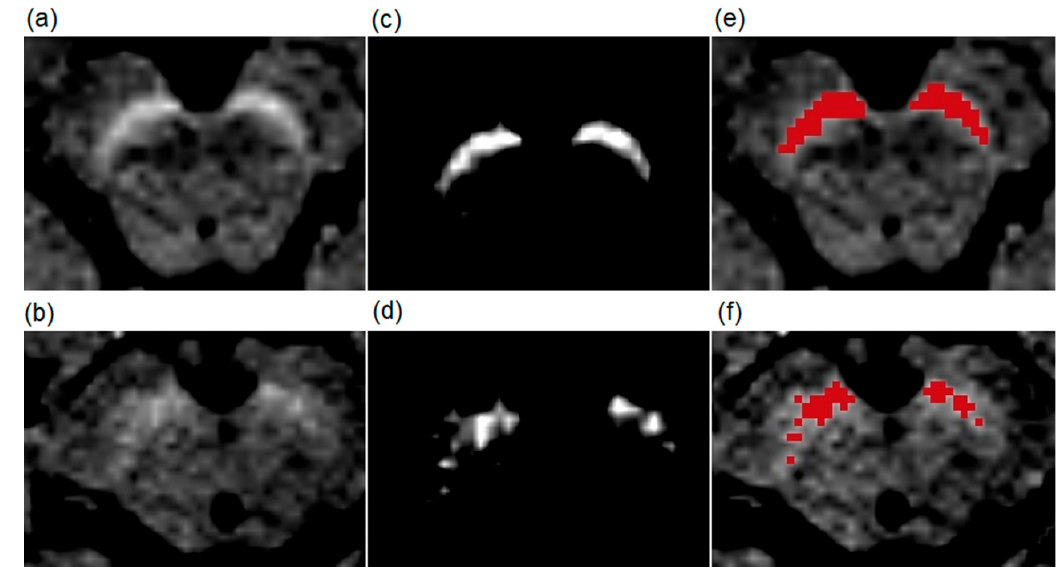
Figure 1. Examples of T1-weighted spectral pre-saturation with inversion recovery (SPIR) images of a patient (70-year-old male) with Parkinson’s disease and a healthy subject (73-year-old male). The upper row shows images from the healthy volunteer, and the lower row images from the patient. ( a , b ) are native T1-weighted SPIR magnetic resonance (MR) images. The results of the manual segmentation method are presented in ( c , d ). The bright areas are the left and right substantia nigra (SN) at the level of the highest hyperintensity. ( e , f ) show red-colored SN surface after the manual segmentation.